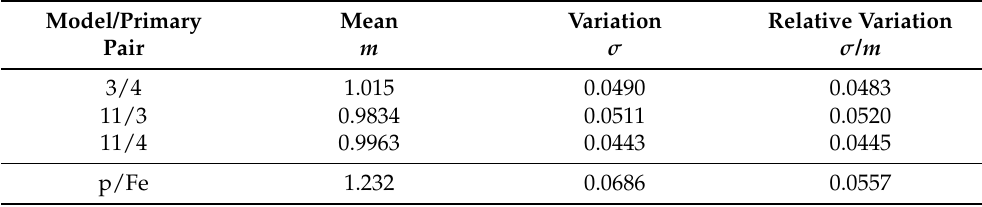
Table 3. Total Cherenkov photons numbers ratios for different CORSIKA atmosphere model pairs: means, variations, relative variations given for 10 PeV primary protons. Zenith angle 15 ◦ . Sample volume 30